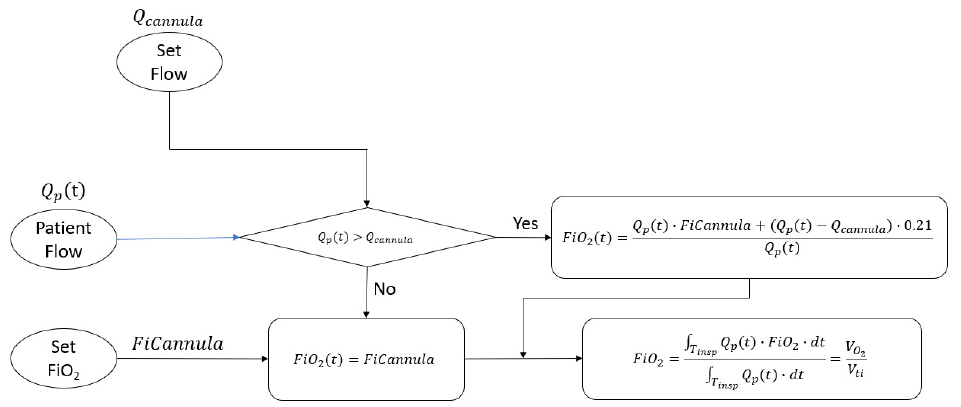
Figure 3. The derivation of tracheal F (cid:2919) O (cid:2870) considering the actual patient fl ow and the dilution of the oxygen when patient fl ow may become greater than the cannula fl ow.